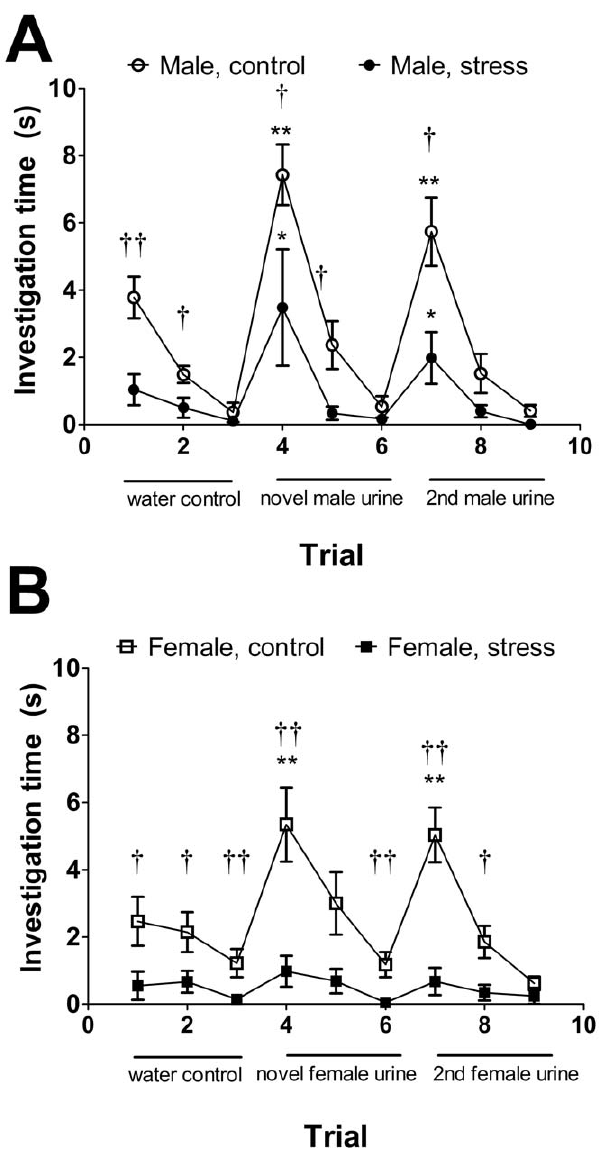
Figure 8. Effects of social defeat on time spent in the center (A) and total activity (B) in the open field test and time spent on the light side of the light-dark box test (C). * main effect of sex p , 0.05. All data are mean 6 s.e.